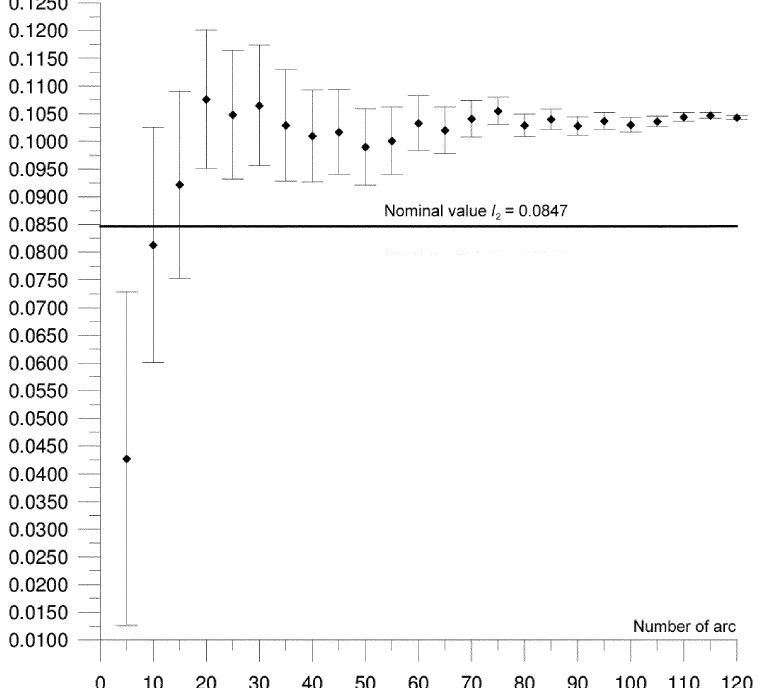
Fig. 2. The sequential solution for the local Shida number l 2 for the Riga station estimated in the combined analysis based on data for LAGEOS-1 and LAGEOS-2. The final adjusted value (for 120 arcs) of the local Shida number l 2 is 0.1043 ±